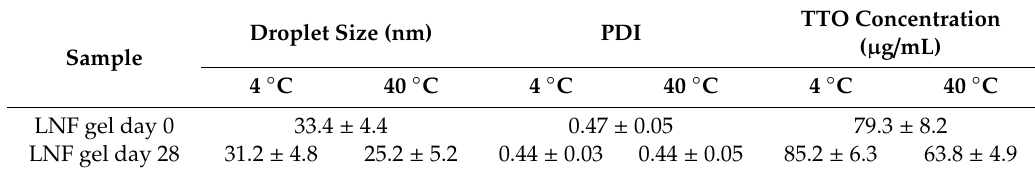
Table 5. Stability study of optimized TTO-LNF gel (mean ± SD, n =